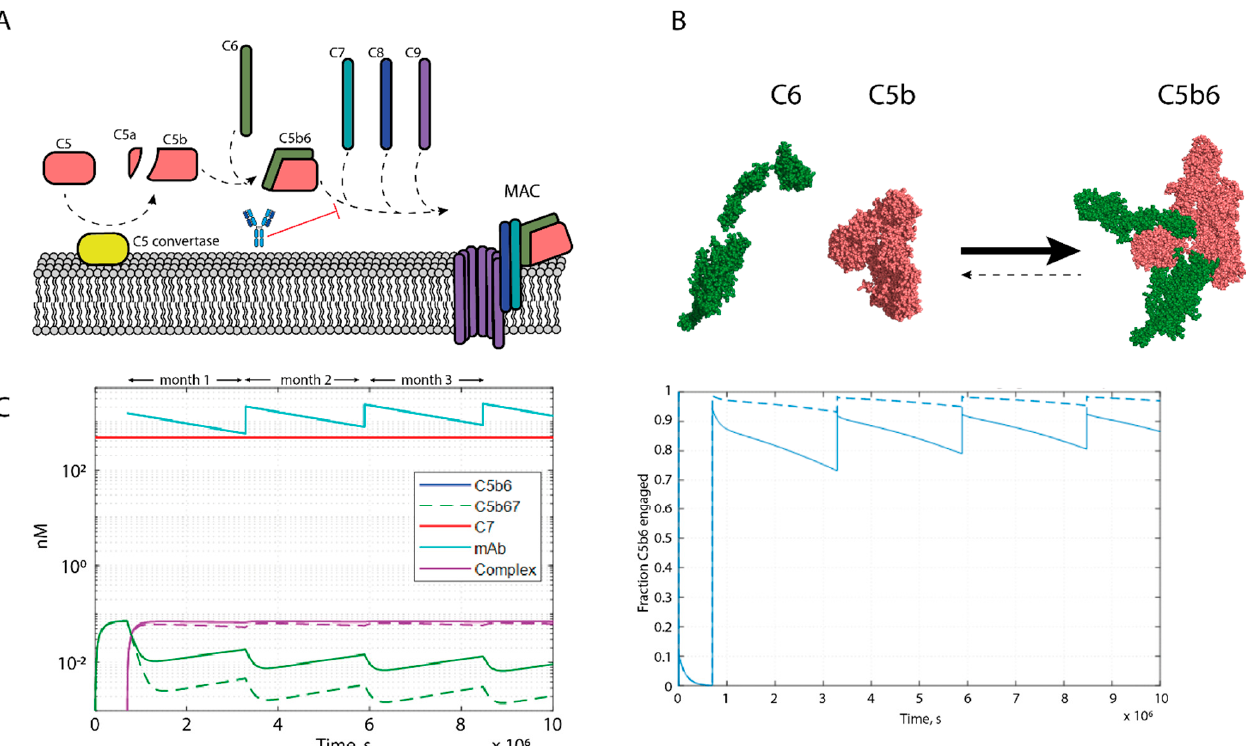
Figure 1. Schematics of biology, desired molecule and antibody selection strategy. ( A ) Schematic representation of membrane attack complex formation, indicating the interaction targeted by the proposed therapeutic. ( B ) Space filling representations of the atomic models of C6 (PDB: 3T5O), C5 (PDB: 3CU7) and C5b6 (PDB: 4A5W), illustrating the formation of neoepitopes. ( C ) Dose prediction modelling of an anti-C5b6 antibody with 1 pM affinity and an on-rate of 1 × 10 7 Ms − 1 and onthly dosing of 10 mg/kg. Simulation carried out for both reported C7 − C5b6 on-rates; 4 × 10 5 Ms − 1 (dashed line) and 2 × 10 6 Ms − 1 (solid line). Fraction target engagement plotted on the right.